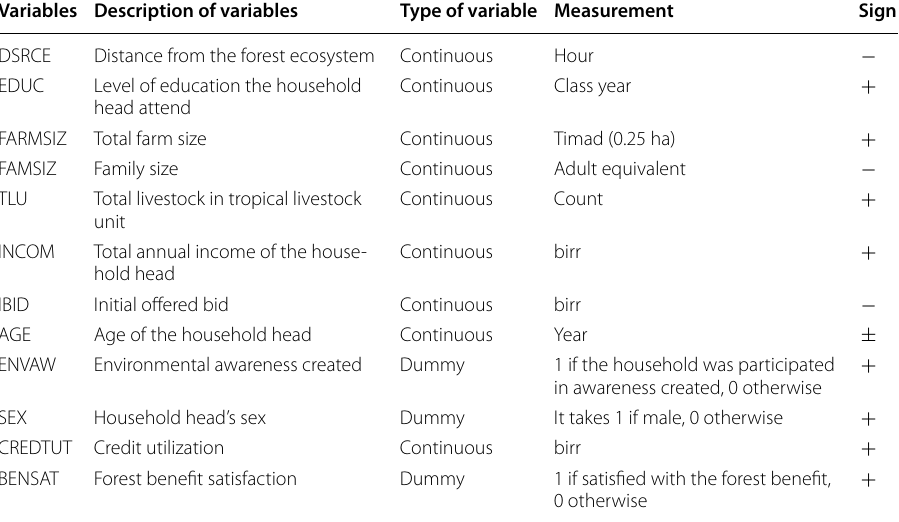
Table 1 Descriptions and expected signs of the explanatory variables. Source: Self-computation,